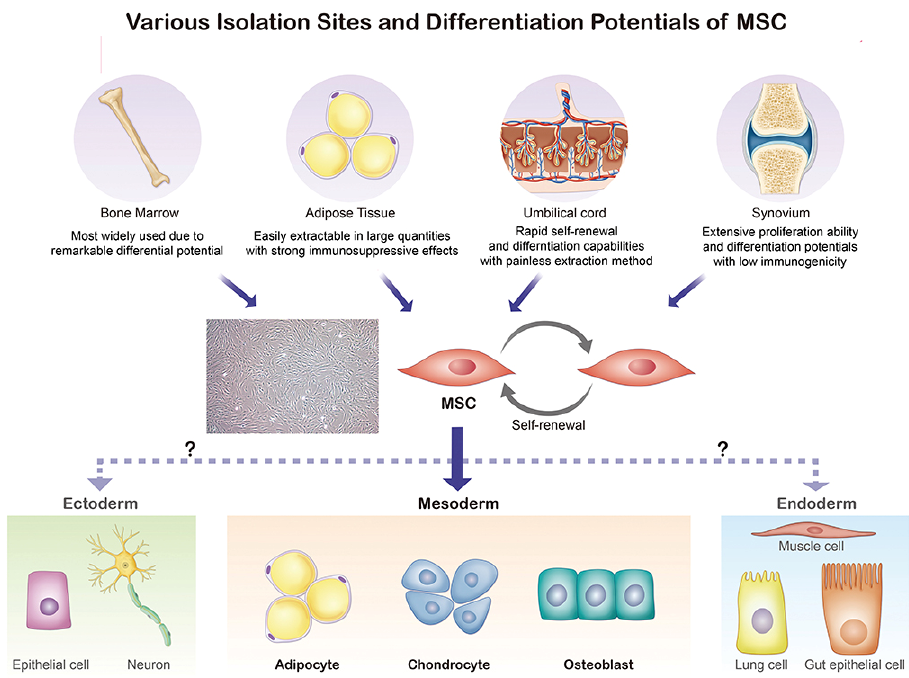
Figure 2. Origin and differentiation directions of MSCs. Reprinted from [24]. MSC, mesenchymal stem cell.